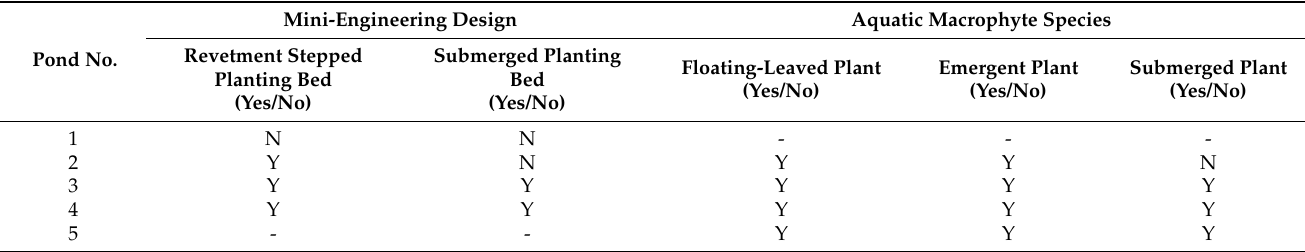
Table 2. Mini-engineering design and aquatic macrophyte configuration of each pond.